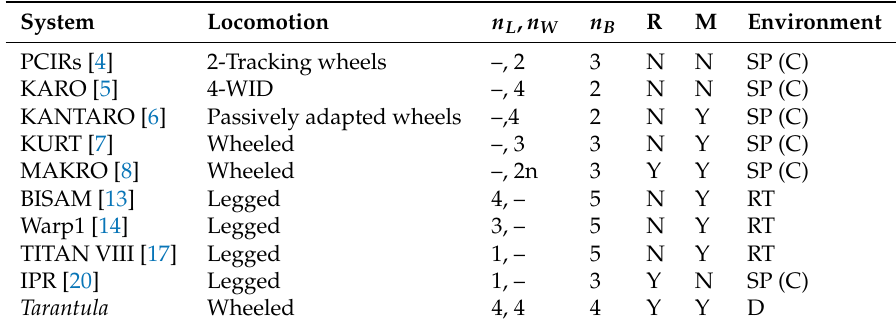
Table 1. Wheeled and legged robot discussed in this